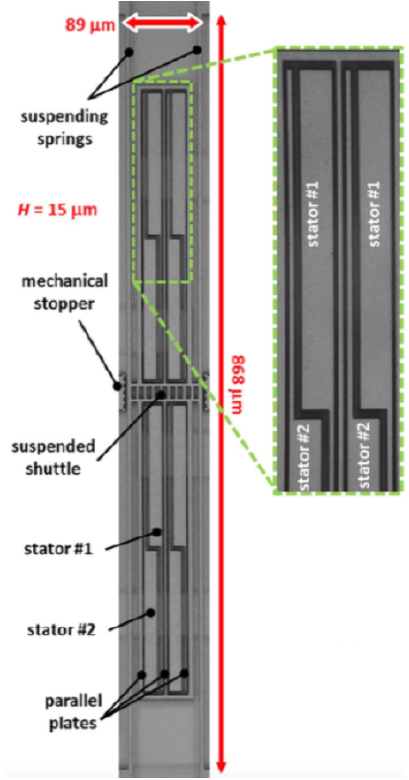
Figure 12. Microphotography of the main components of a MEMS magnetic field sensor with capacitive sensing [28]. Reprinted with permission from [28]. Copyright© 2013, IEEE.